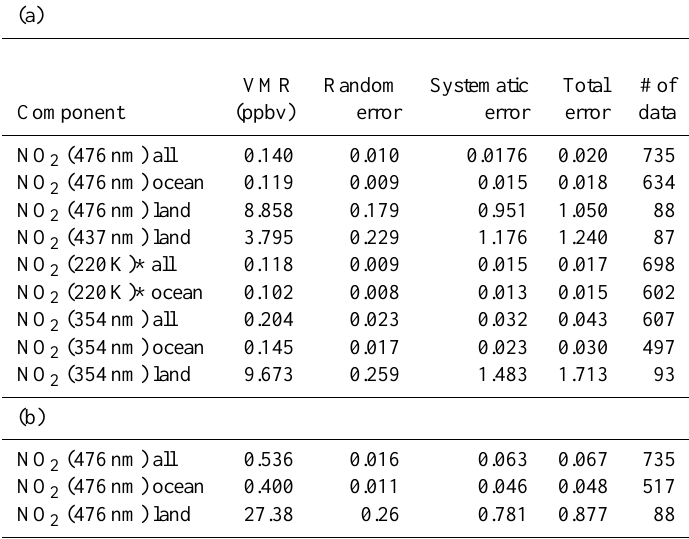
Table 2. (a) Median values of retrieved NO 2 (volume mixing ratios (VMR) in the 0–1km layer; ppbv) and estimated errors (ppbv)